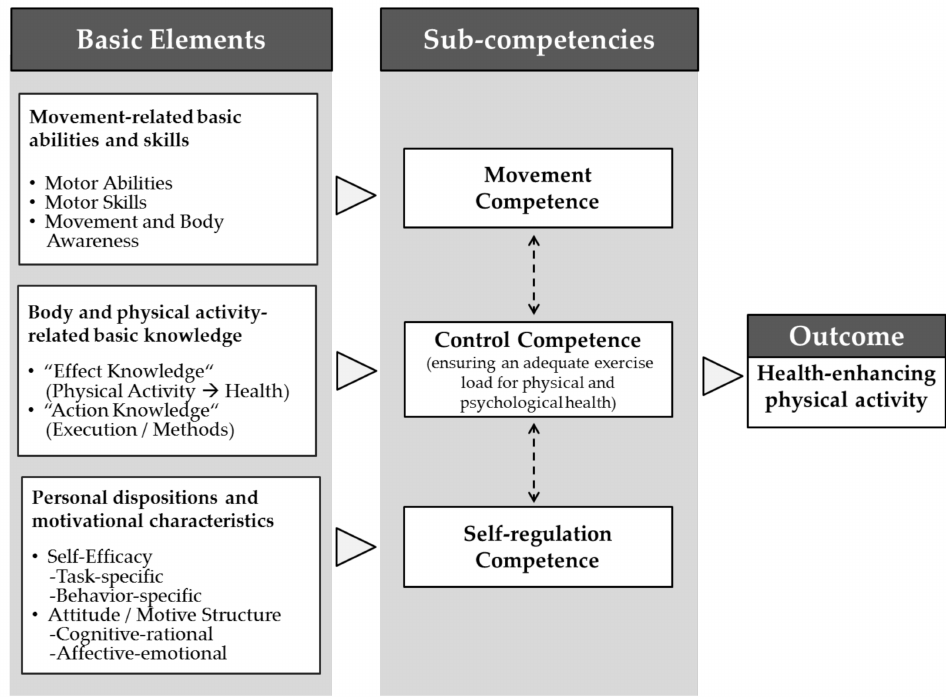
Figure 1. The Physical Activity-related Health Competence (PAHCO) model